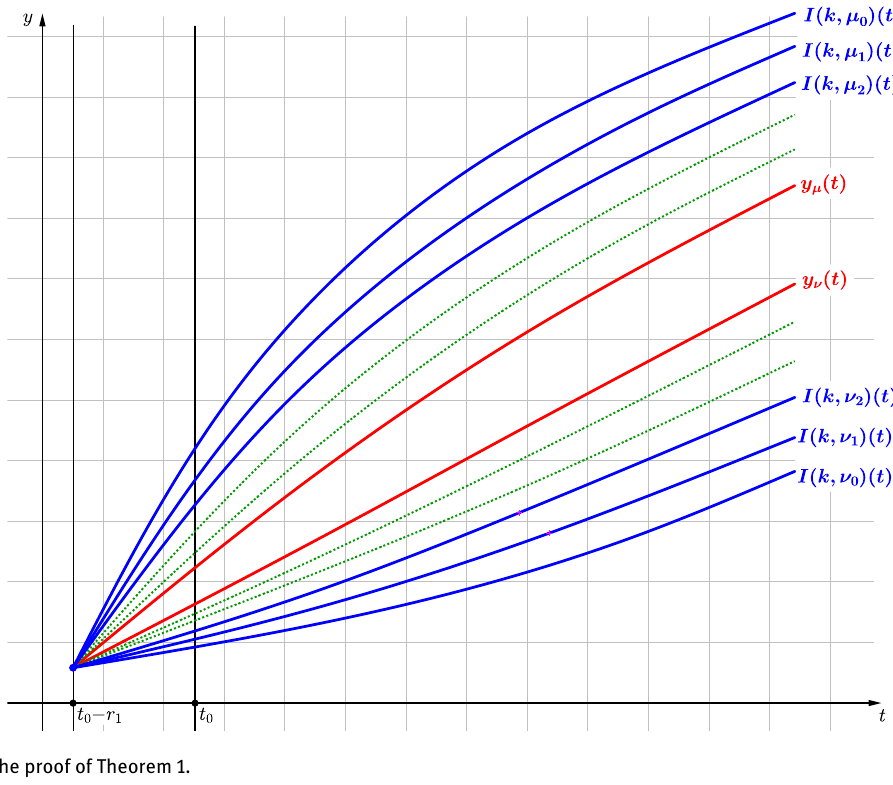
Fig. 2: To the proof of Theorem